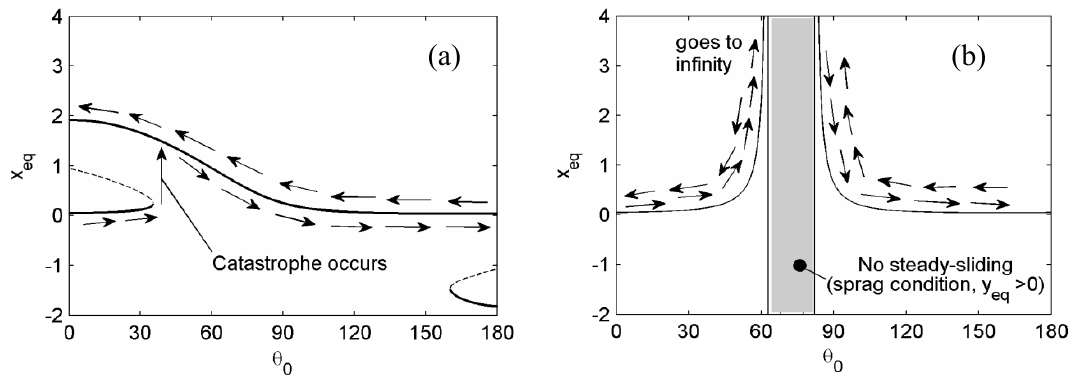
Figure 6. Trajectory of equilibrium with respect to θ o at µ o = 0.7, ( a ) nonlinear model and ( b ) linear sprag model.